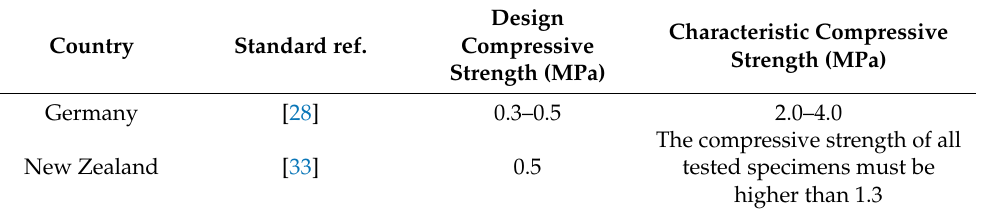
Table 2. Design compressive and characteristic compressive strength of rammed earth.